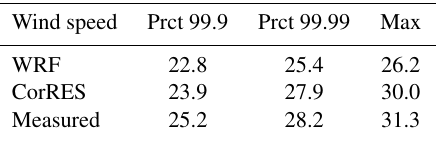
Table 2. Extreme (fleet-level mean) wind speed validation by com- paring high percentiles (Prct) and